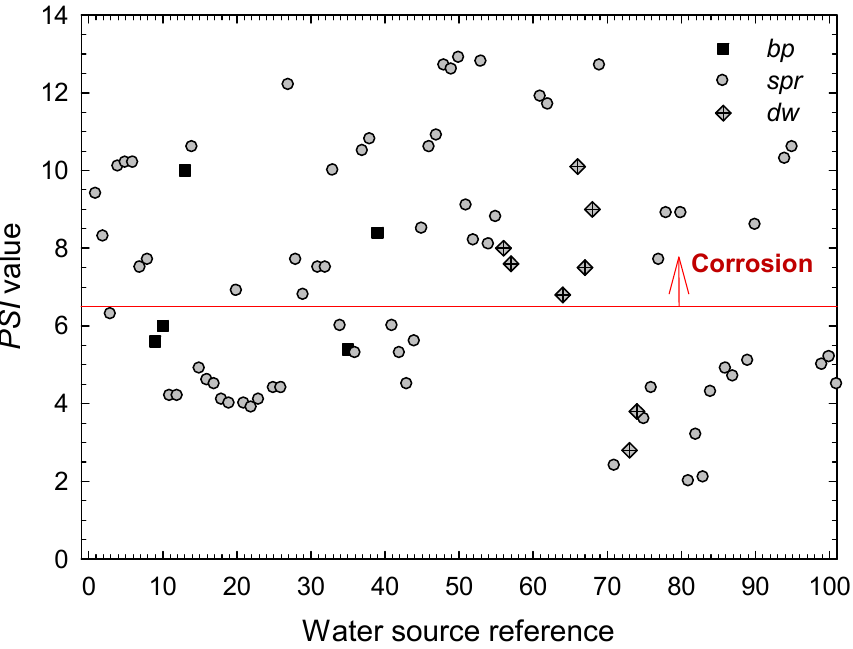
Figure 3. Distribution of the water sources in the Azores archipelago according to their Puckorius Scaling Index (PSI).